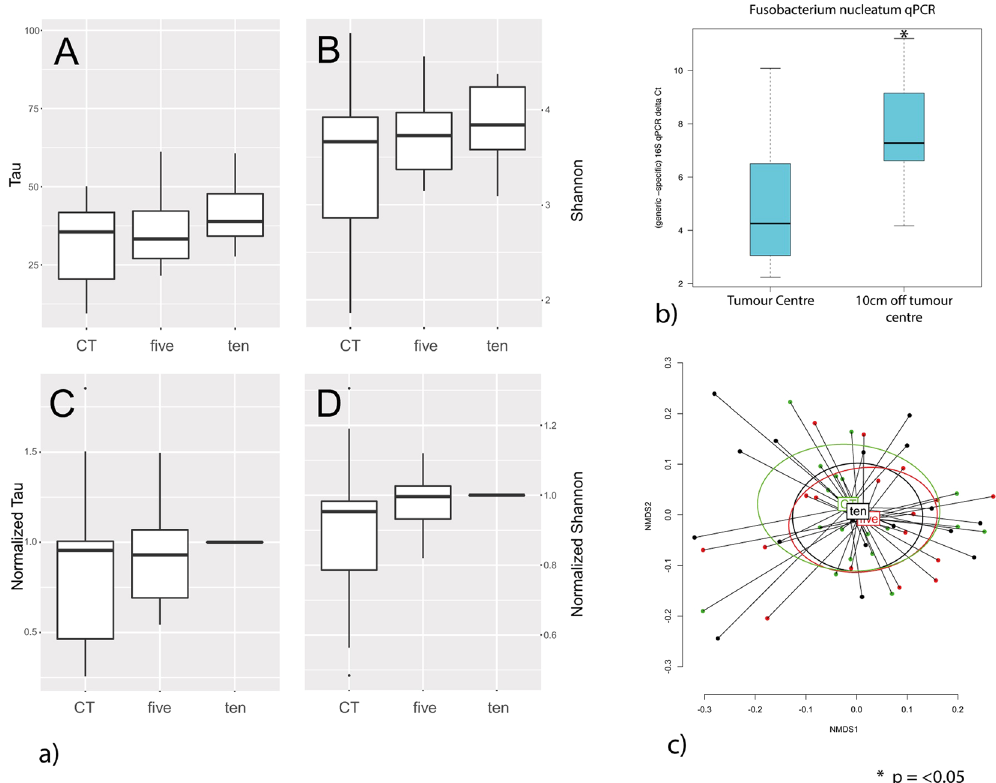
Figure 1. (a) Boxplots of the ecological Indices for the tumour (CT, n = 18), 5 cm off the tumour (five, n = 18) and 10 cm off the tumour (ten, n = 18). Each boxplot was calculated from the individual Tau index (A), Shannon index (B), Normalized Tau (values normalized to the on tumour (CT) value for each individual) (C) and Normalized Shannon (values normalized to the on tumour (CT) value for each individual) (D). No statistical differences were observed between the values. ( b ). Box plot of Fusobacterium nucleatum 16 S qPCR data, demonstrating over-representation of Fusobacterium nucleatum on cancer, when compared to mucosa biopsied at 10cms (p < 0.05). ( c ). PCA plot of non-metric multi-dimensional scaling of OTU data from 18 patients in